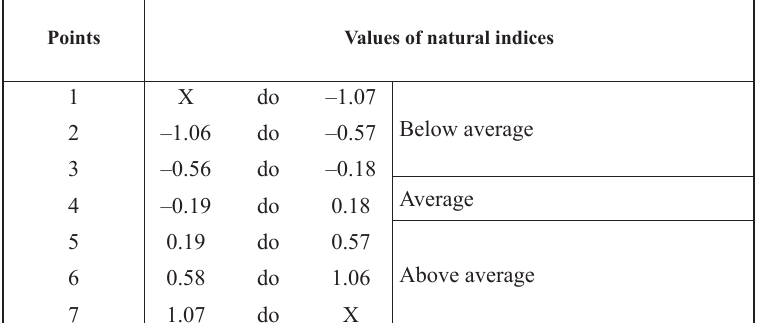
Table 1. Scale of points of Perkal’s (1953) natural indices